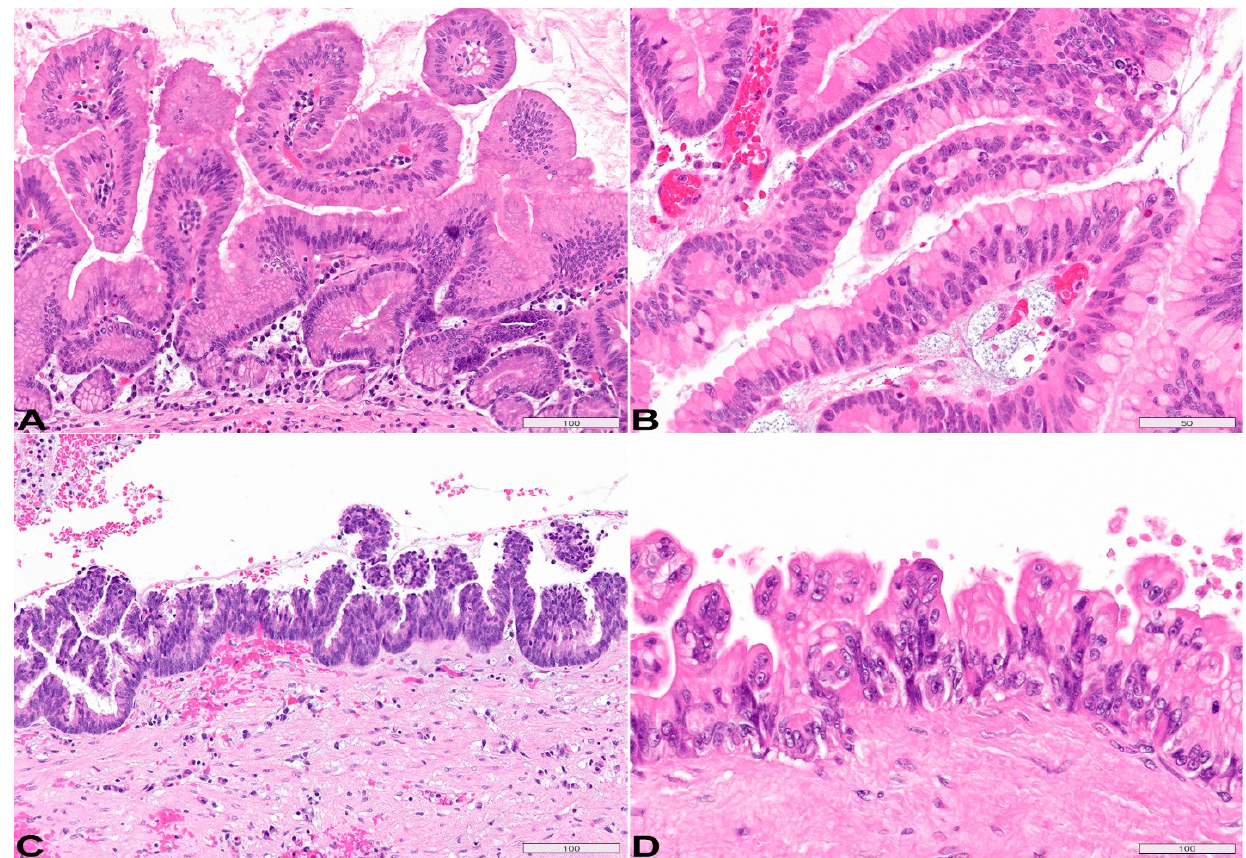
Figure 4. Two-tiered histologic grading of IPMN: Low-grade and high-grade. ( A ) showing low- grade epithelium that arranges into tall papillae, but notice the bland cytology and abundant cyto- plasmic mucin. ( B – D ) High-grade dysplasia feature severe atypia, characterized by papillae with irregular branching and budding, nuclear stratification with loss of polarity, cellular pleomorphism, increased mitoses and variably decreased cytoplasmic mucin. Of note, with increasing dysplasia, the papillae may become shorter/smaller and lose central fibrovascular stromal core. In comparison to the low-grade large thick papillae in ( A ), the high-grade papillae are shorter without stromal core (( B ), center slender papillae; ( C , D ), short stubby papillae). H&E stain, original magnification, ( A , C , D ) 200 × ; ( B ) 400 × . Scale bars, in µ